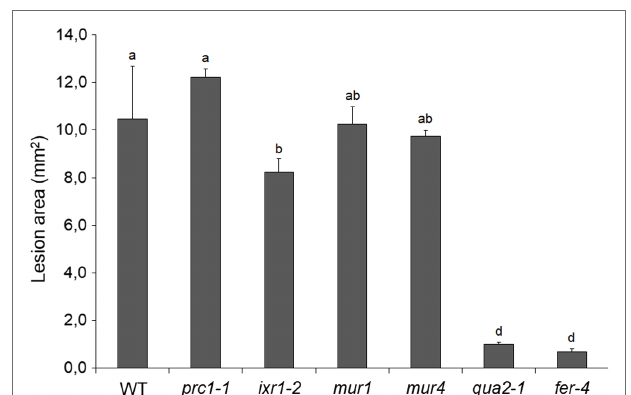
FIGURE 8 | Resistance to B. cinerea in cell wall mutants. Rosette leaves of five-week-old WT plants and of prc1 , ixr1-2 , mur1 , mur4 , qua2 , and fer-4 mutant plants were inoculated with a B. cinerea spore suspension, and lesion area was measured 2 days after inoculation ( n > 12 lesions for each genotype). Bars indicate average lesion area ± SE . Different letters indicate statistically significant differences, according to one-way ANOVA followed by Tukey’s significance test ( p <